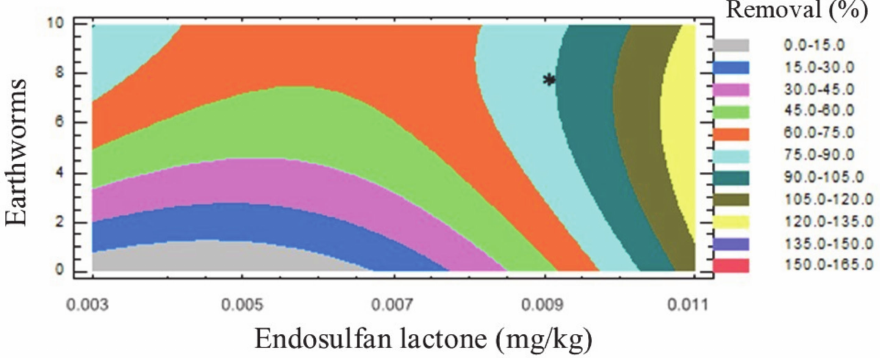
Figure 7. Representation of the response surface using the contour plot for endosulfan lactone removal on day 5 in non-sterile solid